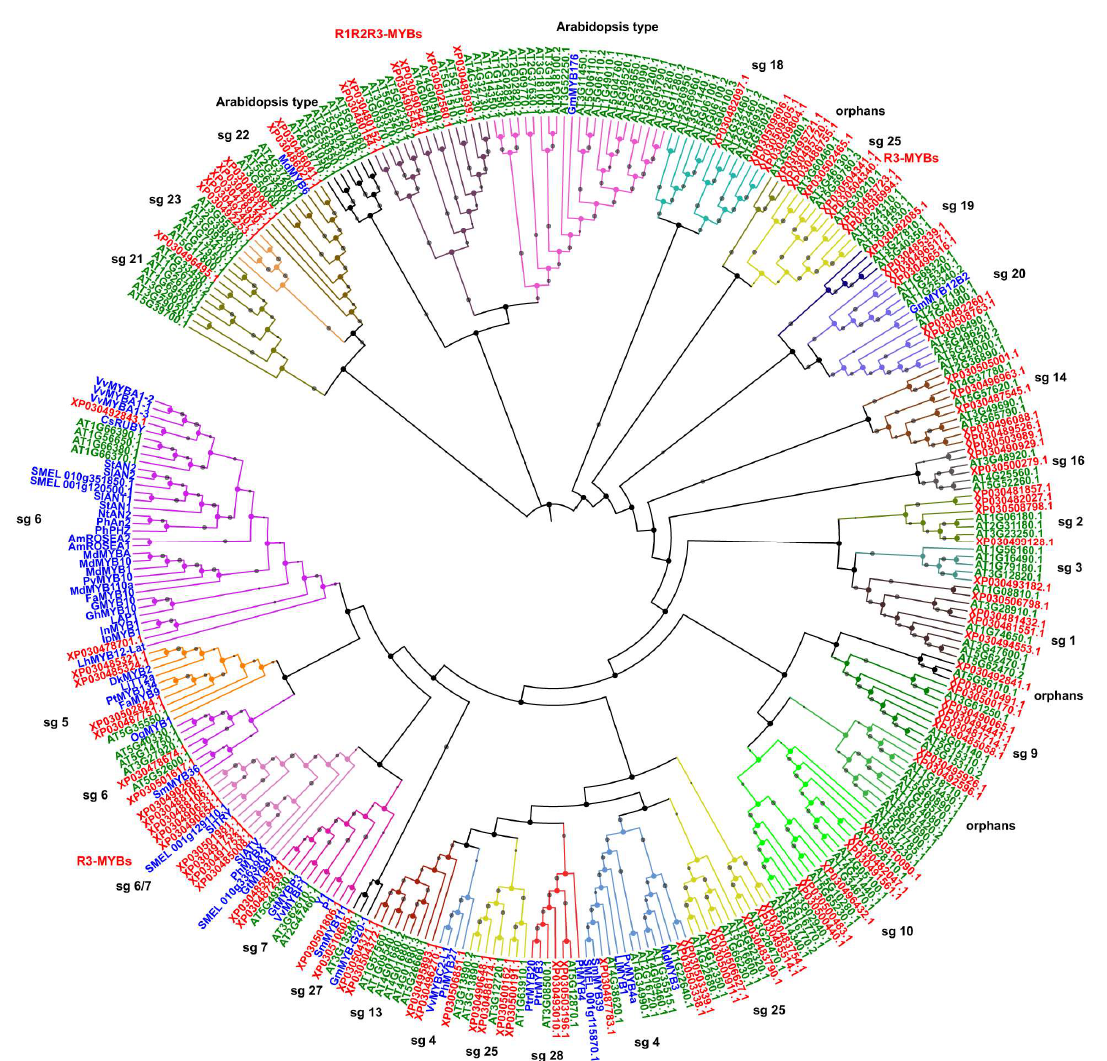
Figure 4. Comparative phylogenetic tree and classification of MYB proteins in Cannabis sativa and Arabidopsis thaliana . The optimal tree (sum of branch length = 69.59273343) is shown. The tree is drawn to scale, with branch lengths in the same units as those of the evolutionary distances used to infer the phylogenetic tree. The percentage of replicate trees in which the associated taxa clustered together in the bootstrap test (1000 replicates) is displayed next to the branches as gray circle with size ranging from 1 to 5. Branches corresponding to partitions reproduced in less than 50% bootstrap replicates are collapsed. The genome-wide analysis involved 330 amino acid sequences divided into 30 phylogenetic subgroups marked with di ff erent clade colors and numbers corresponding to known subfamilies. The leaf labels of MYB members from Arabidopsis , Cannabis , and other species are written in green, red, and blue,